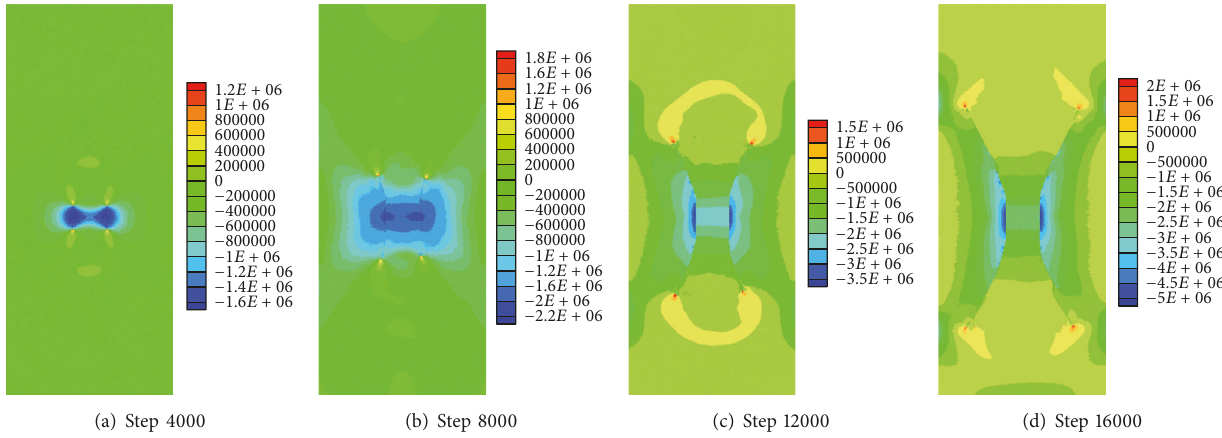
Figure 24: Maximum principal stress contours under an isotropic in situ stress field (positive denotes tension).